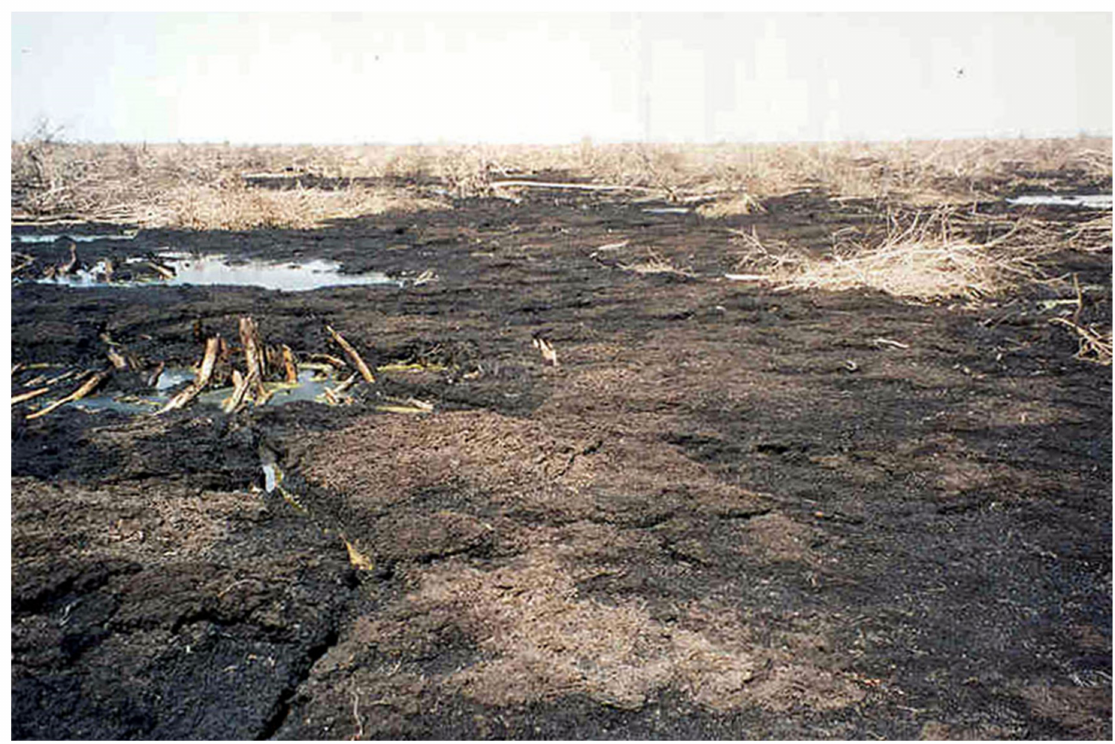
Figure 3. Vulnerability of tropical peatlands illustrated by the effects of fire on one of the last remaining peat masses in the Mekong Delta at U Minh Tong, Vietnam. Source: Edward